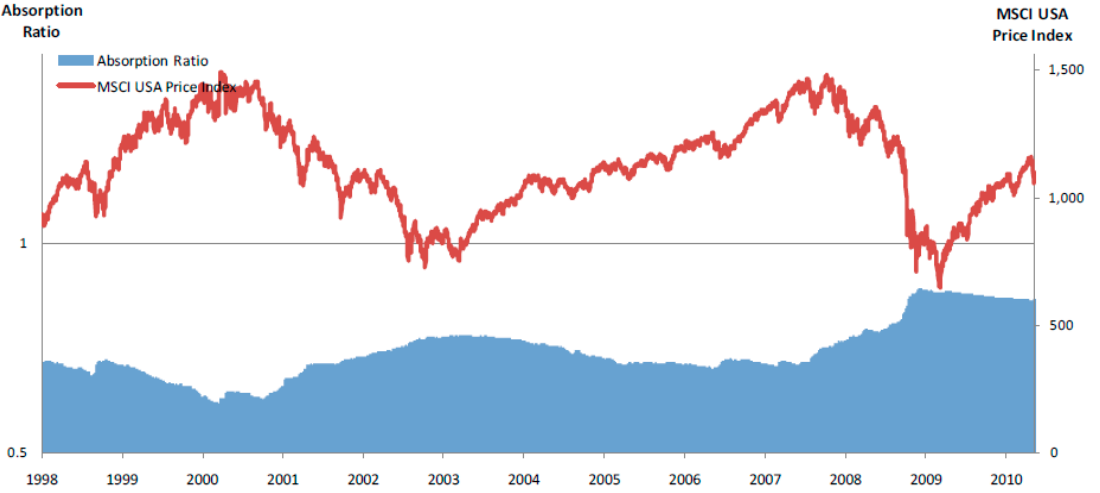
Figure 1. Absorption Ratio vs MSCI USA Index (From [1] Kritzman et al. 2010, reprinted in